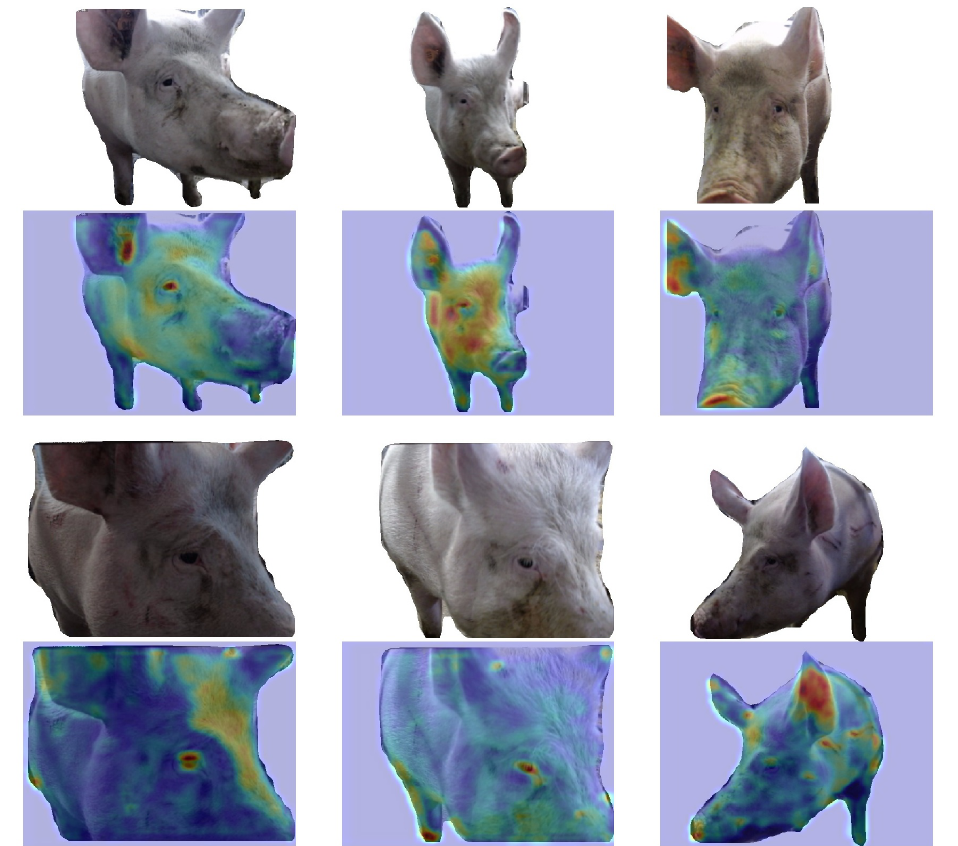
Figure 7. Six Grad-CAM heatmaps from correctly predicted conditions for unstressed (top three), and stressed pigs (bottom three). The input image is also included for easier comparison above each heatmap. Note the repeated use of the eye region, although it appears that other regions are also used. These images also show the range of lighting conditions that the model is able to cope with. NB red regions indicate a high level of activation; blue regions indicate a low level of